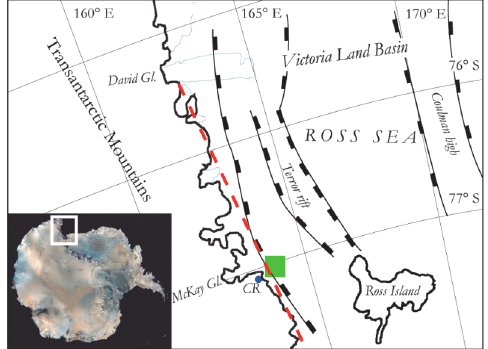
Fig. 2. Location of Cape Roberts area. Red dashed line: McMurdo sound fault system, simplified from (Ferraccioli et al ., 2003).